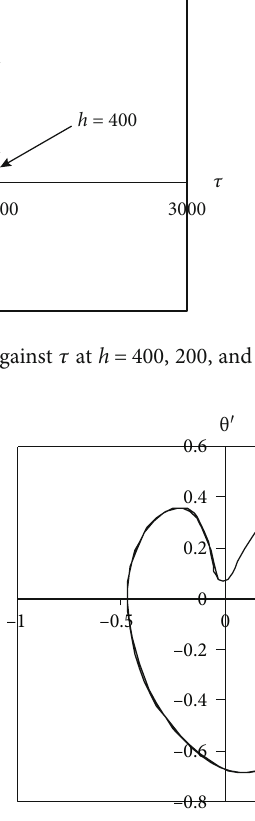
Figure 7: The analytical and numerical stabilities θ ′ against θ at h = 200 .